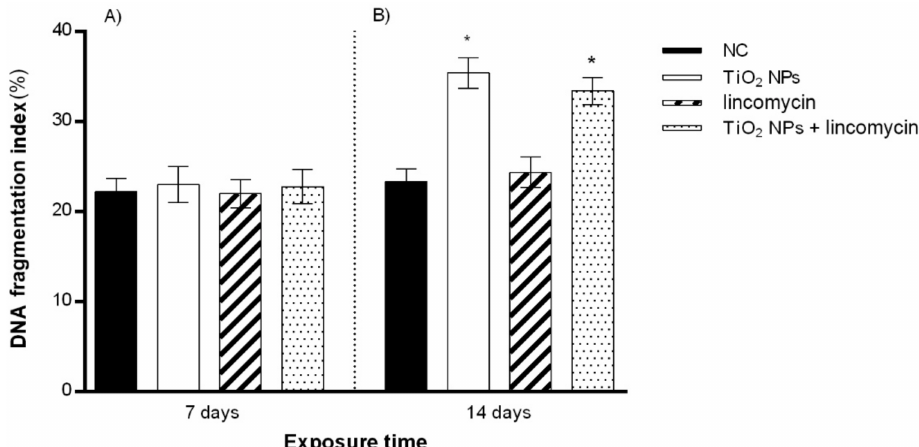
Figure 3. Percentage of DNA fragmentation in zebrafish blood cells (ordinate) after 7 days of exposure ( A ) and after 14 days of exposure ( B ) to TiO 2 NPs alone, lincomycin alone, and TiO 2 NPs and lincomycin in combination (abscissa). The dark bars are the negative control (NC); the white bars are 10 µ g/L TiO 2 NPs treated specimens (TiO 2 NPs); the striped bars are 100 mg/L lincomycin treated specimens (lincomycin); and the dotted bars are 10 µ g/L TiO 2 NPs + 100 mg/L lincomycin treated specimens (TiO 2 NPs + lincomycin); * p ≤ 0.05 in comparison with the NC.